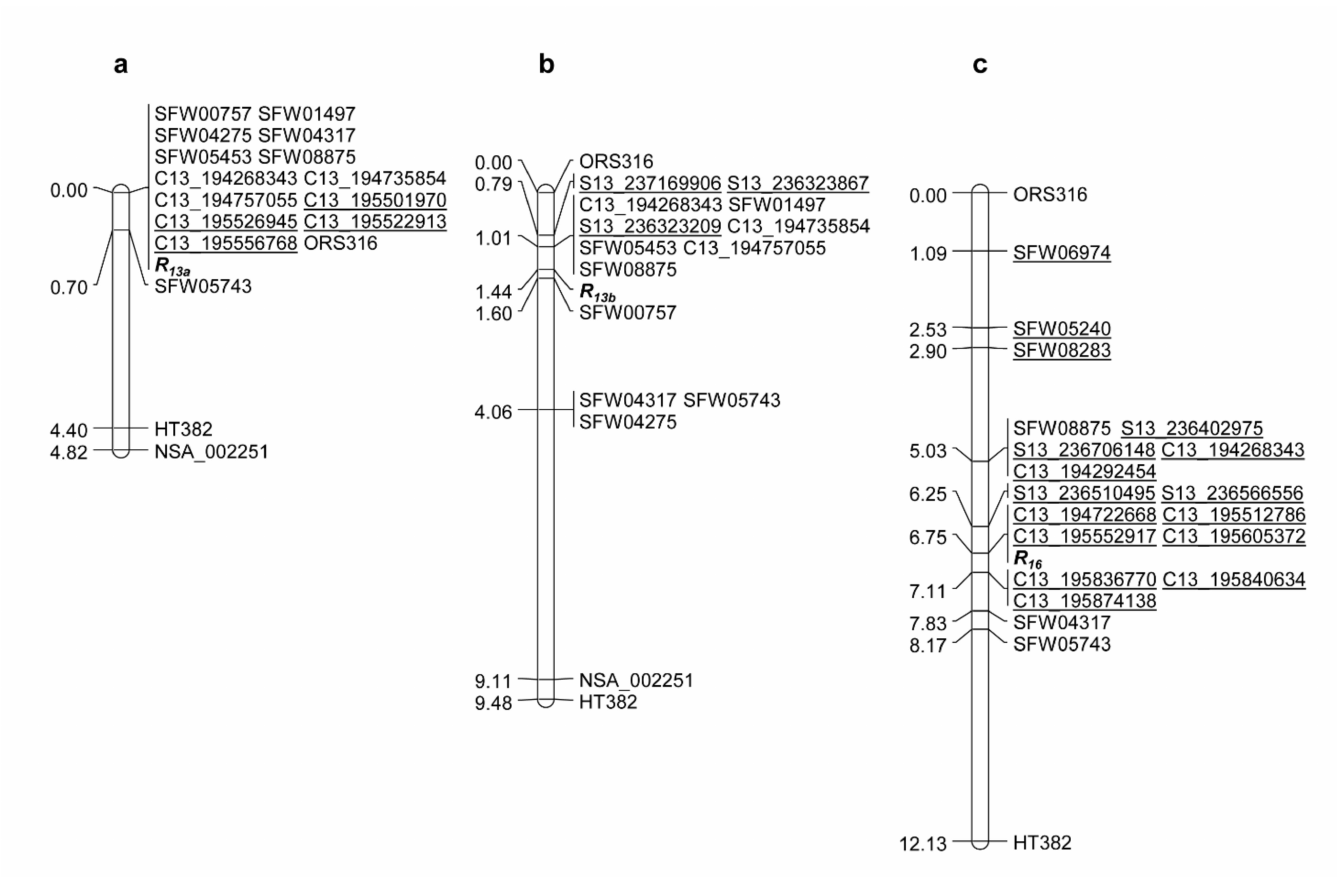
Figure 4. Genetic maps of R 13a , R 13b and R 16 . ( a ) R 13a saturation map, ( b ) R 13b saturation map, and ( c ) R 16 saturation map. The underlined markers are the unique markers in each